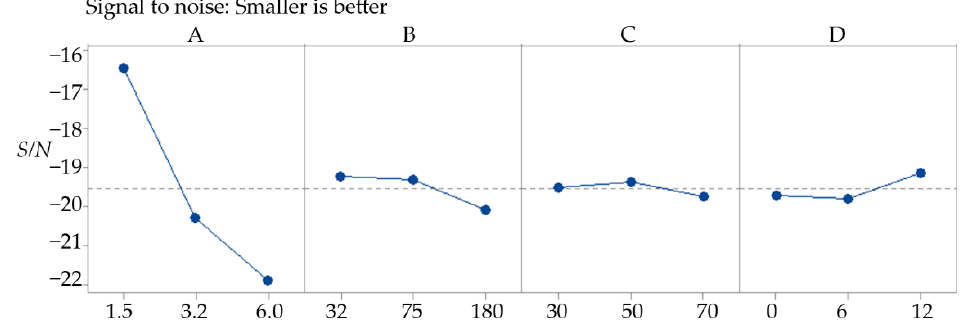
Figure 5. Graphic representation of the S/N ratio for thickness of the defect layer, ( A ) Discharge